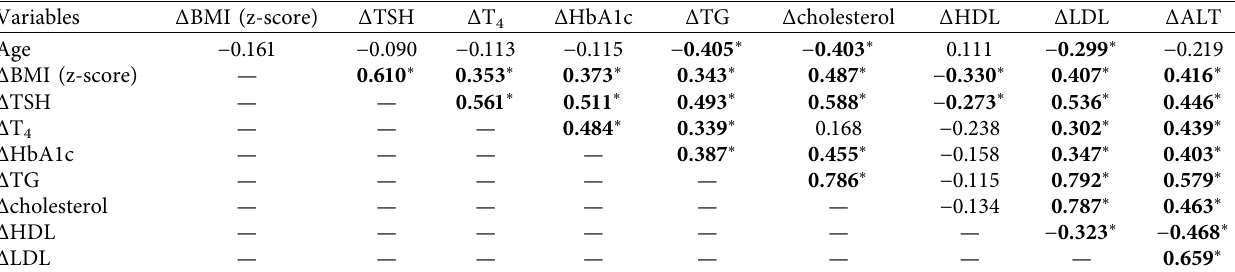
Table 3: Correlation between different clinical and laboratory variables.